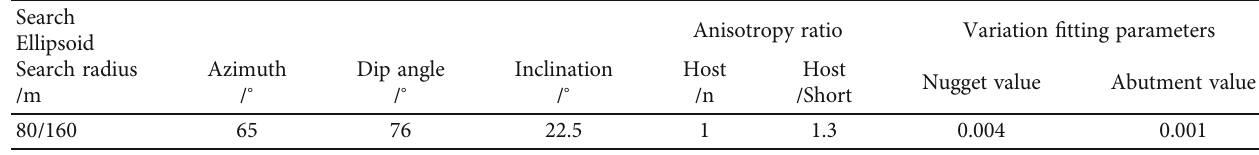
Table 4: Table of anisotropy parameters of variation function.